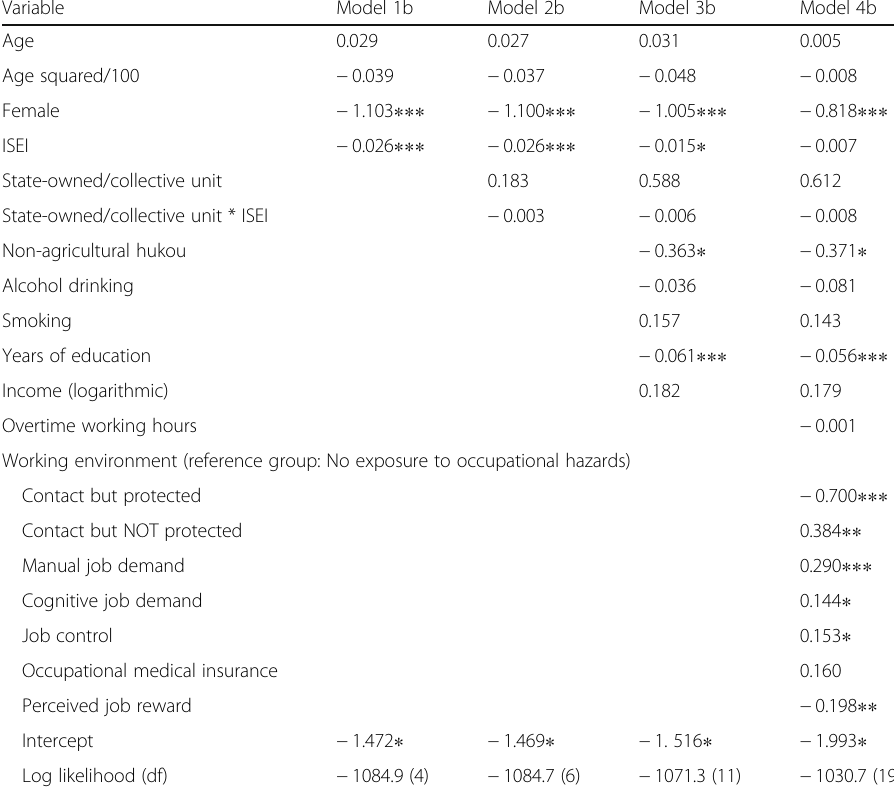
Table 6 Logit models of occupational status and working conditions on work-related injuries ( N = 3940) Variable Model 1b Model